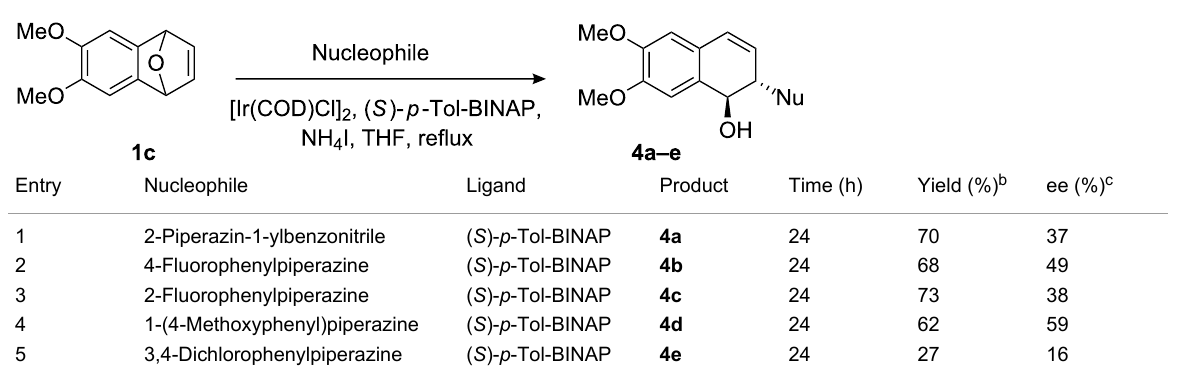
Table 5: Iridium-catalyzed asymmetric ring-opening reaction of substrate 1c . a